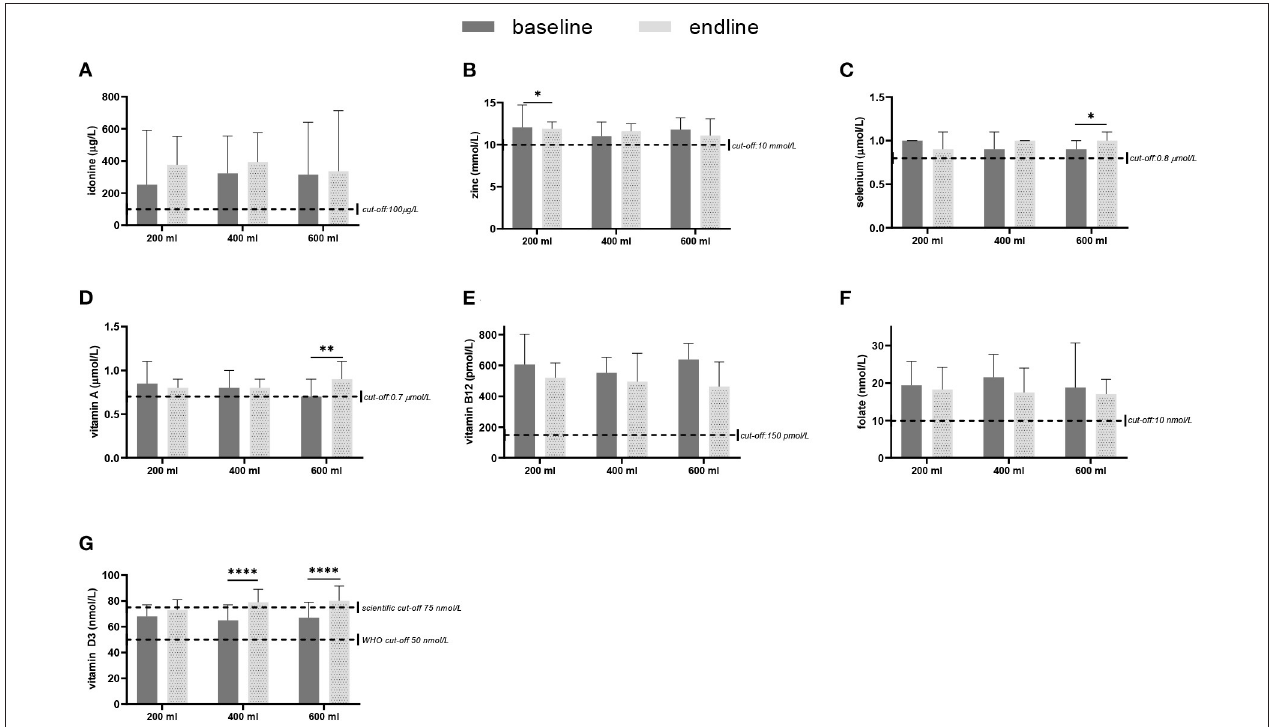
FIGURE 2 | Micronutrient levels in blood or urine, sampled at baseline and after 6 months of intervention with a fortified dairy-based drink in daily amounts of 200, 400 or 600ml, in Nigerian toddlers with malnutrition: (A) Iodine (median + IQR), (B) zinc (mean + SD), (C) selenium (median + IQR), (D) vitamin A (median + IQR), (E) vitamin B12 (median + IQR), (F) folate (mean + SD), and (G) vitamin D3 (median + IQR) for the three study groups at baseline and after the 6 months intervention. The difference between baseline and endline was tested with either a paired t -test or a related-samples Wilcoxon signed-rank test per study group. * p < 0.05, ** p < 0.01, **** p <